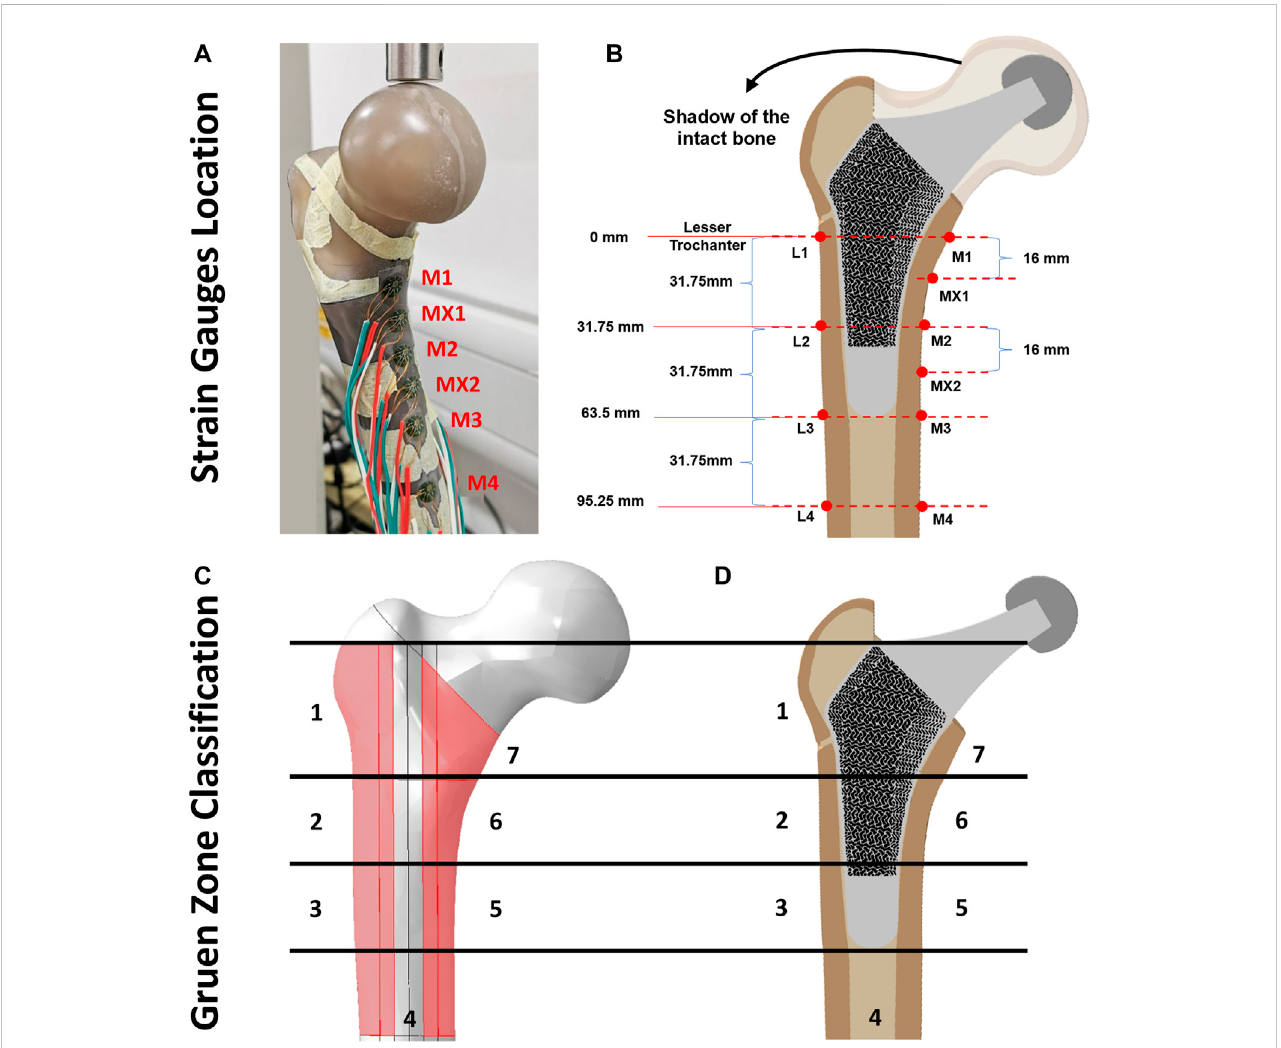
FIGURE 4 (A, B) Illustration of strain gauge locations across cortical bone surface, (C) Gruen zones (1 – 7) on intact femur bone model and (D) section view of the implanted porous